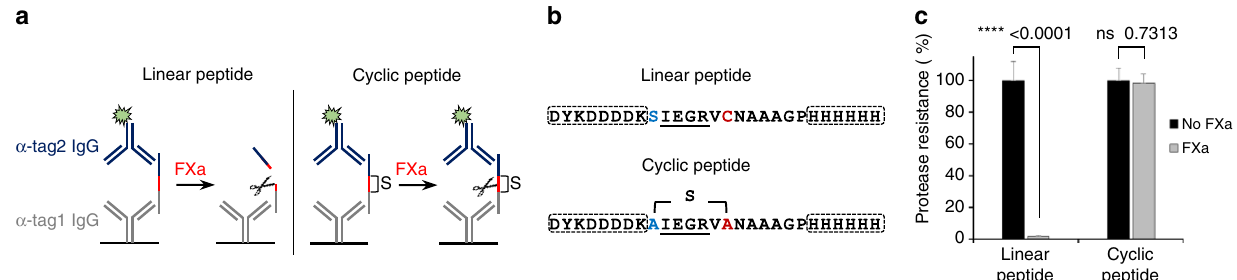
Fig. 1 An ELISA-based reporter assay monitors the cyclization status of arti fi cial lanthipeptides. a Peptides containing an FXa recognition site (red bar) fl anked by af fi nity tags and residues involved in thioether bridge formation are captured via anti-tag1 antibodies, treated with FXa, and detected via anti- tag2 antibodies. Tag2 is proteolytically removed (left panel) in linear peptides, but remains connected via a covalent thioether (indicated by “ S ” , right panel) in cyclic peptides, resulting in low and high signals, respectively. b Sequences of synthetic linear or thioether-bridged peptides with FLAG- and His 6 - epitopes (boxed) fl anking the FXa site (underlined) used for assay validation. c Synthetic peptides were captured via the His 6 -tag, incubated with or without FXa, and detected using anti-FLAG IgG. The protease resistance relative to untreated (no FXa) samples was calculated and data representing mean ± s.d. of three replicates is shown (unpaired, two-tailed t -test). The experiment was repeated three